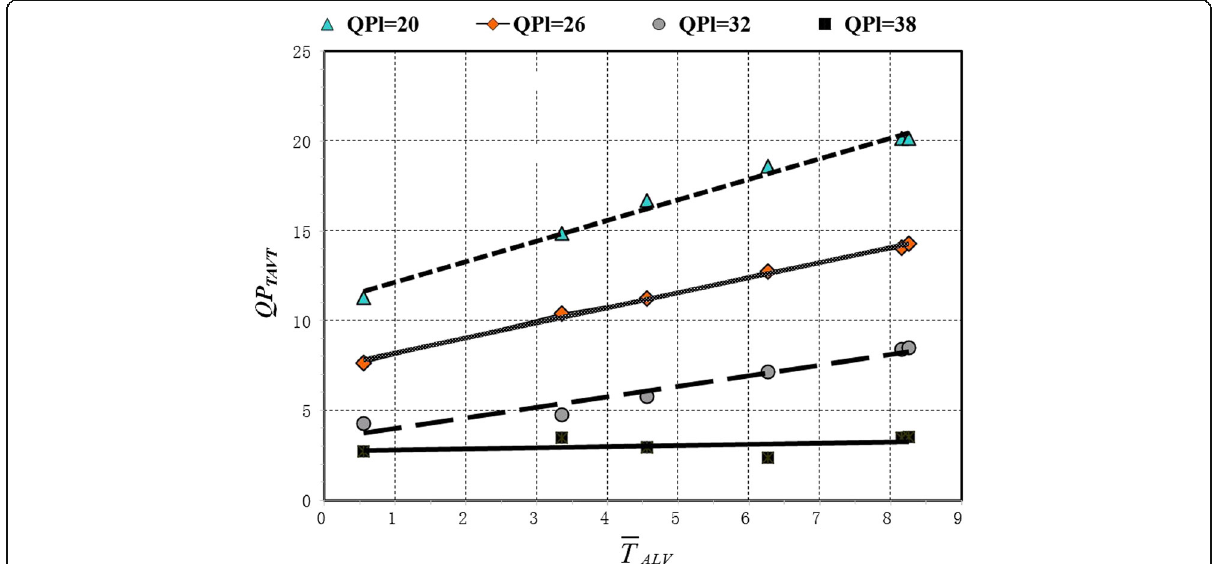
Fig. 4 Linear relationship between QP TAVT and the T ALV under various left view QP l